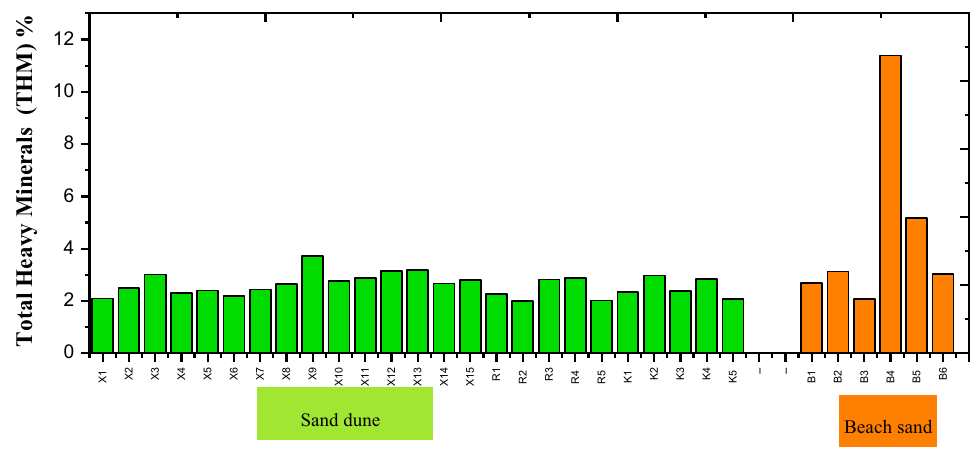
Figure 4. The histogram shows the total heavy minerals distribution among the sand dune and beach sand.